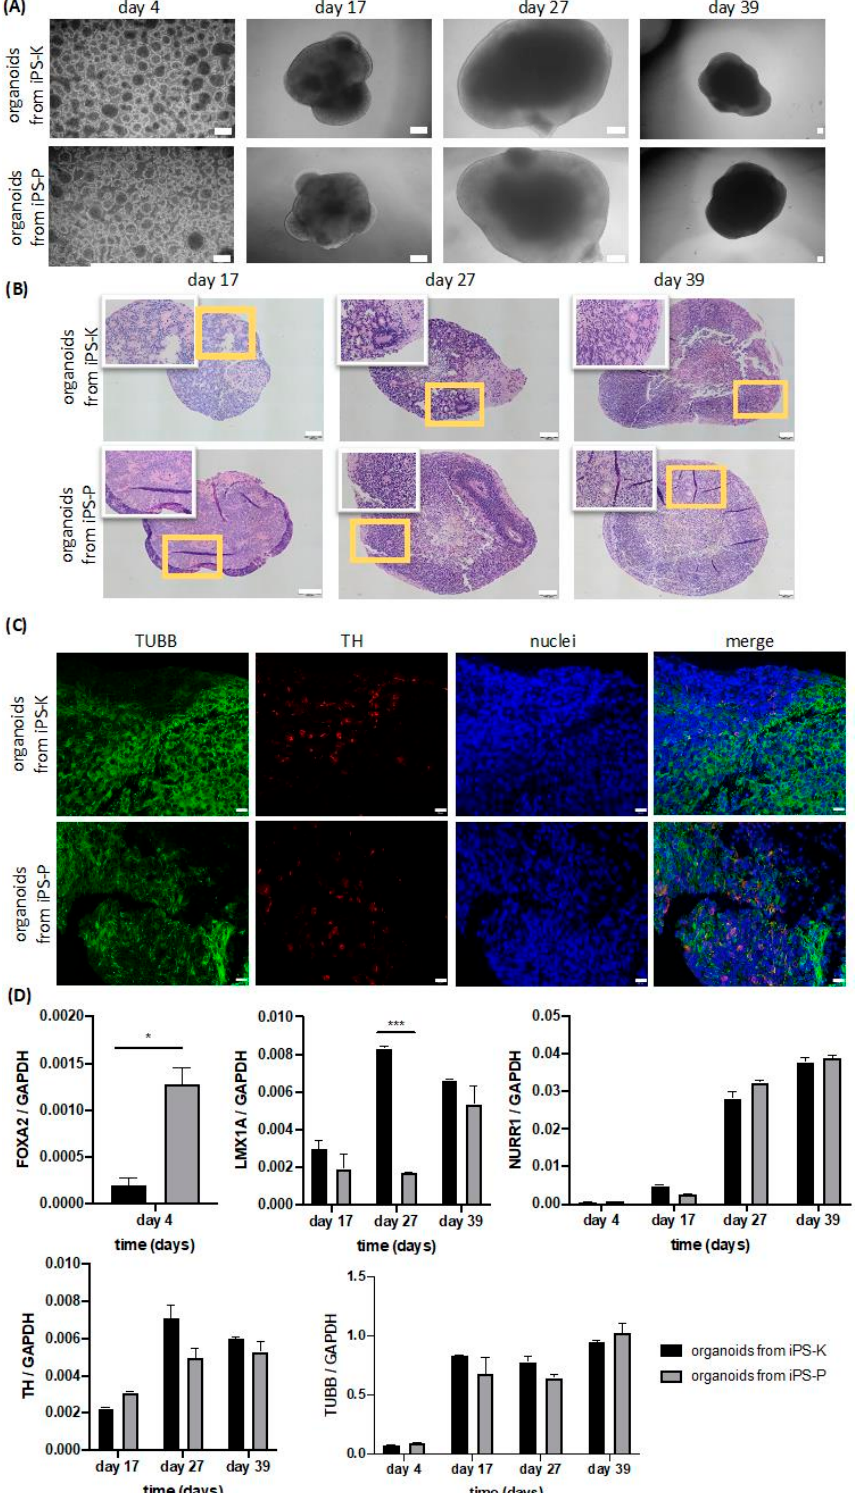
Figure 6. Differences in neuronal cell marker expression levels in organoids generated from iPS cells of differing origin. ( A ) Representative images presenting similar morphology of organoids during culture on days 4, 17, 27 and 39 ( n = 4). White scale bars represent 200 µ m. ( B ) Hematoxylin and eosin staining of organoids on day 17, 27 and 39 showed that organoids from iPS-K generated more structures resembling neuroectodermal rosettes. Yellow frame shows the selected structures in